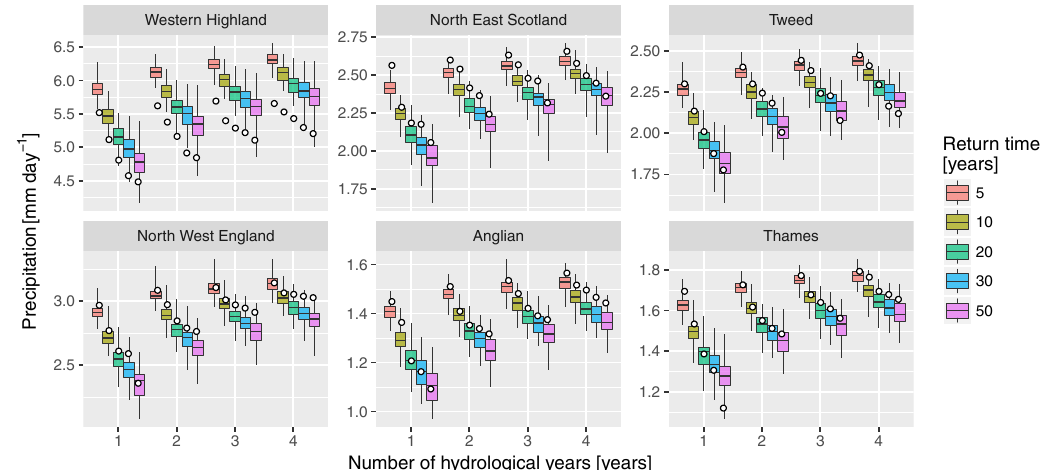
Figure 8. Return values of low precipitation accumulated over 1–4 hydrological years ( x axis) in the 100 baseline time series (box plot) and in CEH-GEAR (white dot) for each region (panel), for return times of 5–50 years. See Fig. S10 for the plots for all regions and Fig. S11 for the same analysis on seasonal precipitation rather than hydrological years. Whiskers display the range from individual time series.